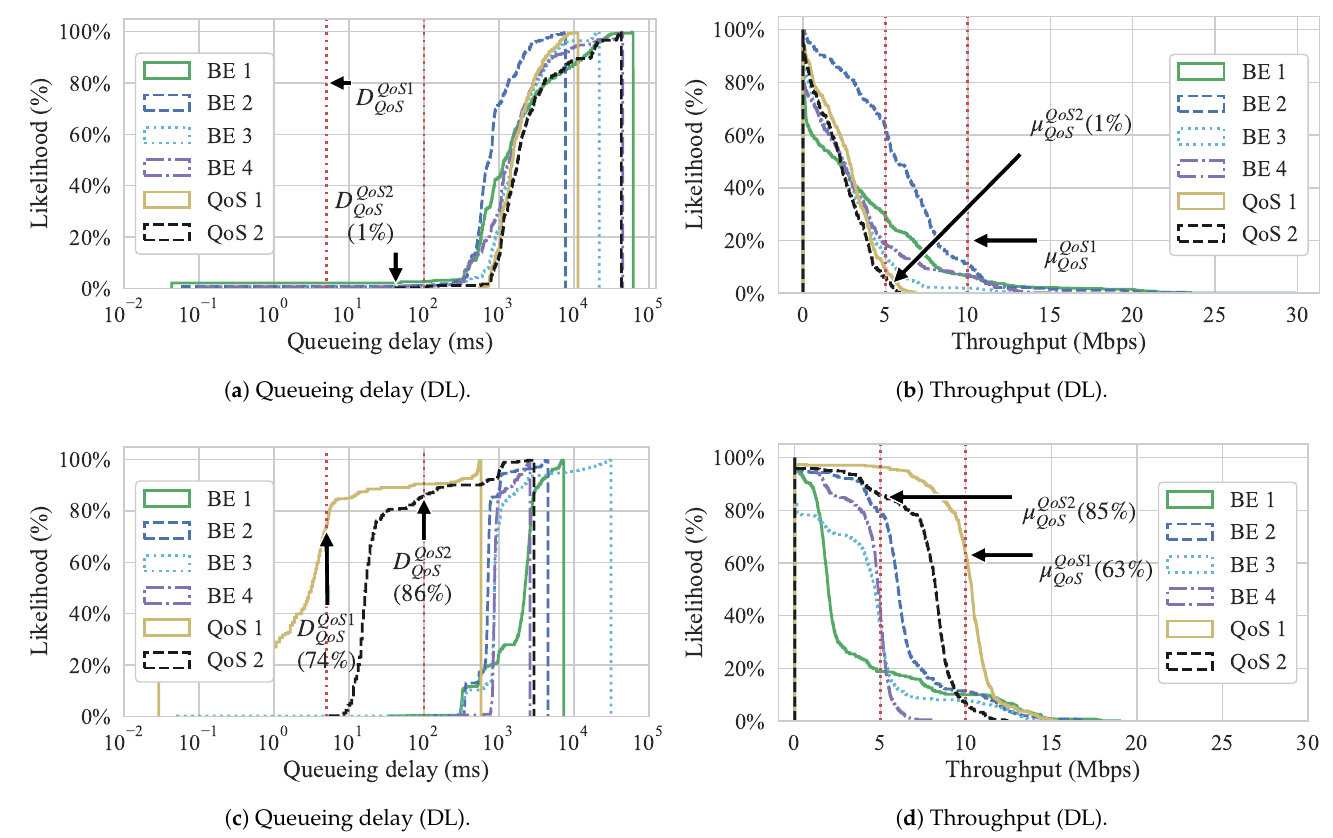
Figure 11. Experiment 2 Cumulative Distribution Functions (CDFs). ( a ) Queueing and ( b ) throughput of slices (DL) with Gómez et al. [5]; ( c ) queueing delay; and. ( d ) throughput of slices (DL) with our